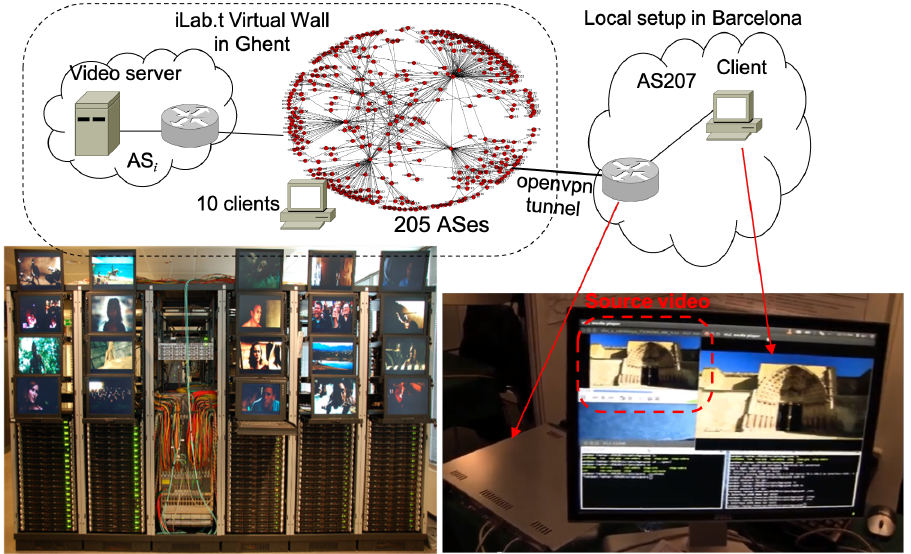
Figure 9. Setup of the experiments.